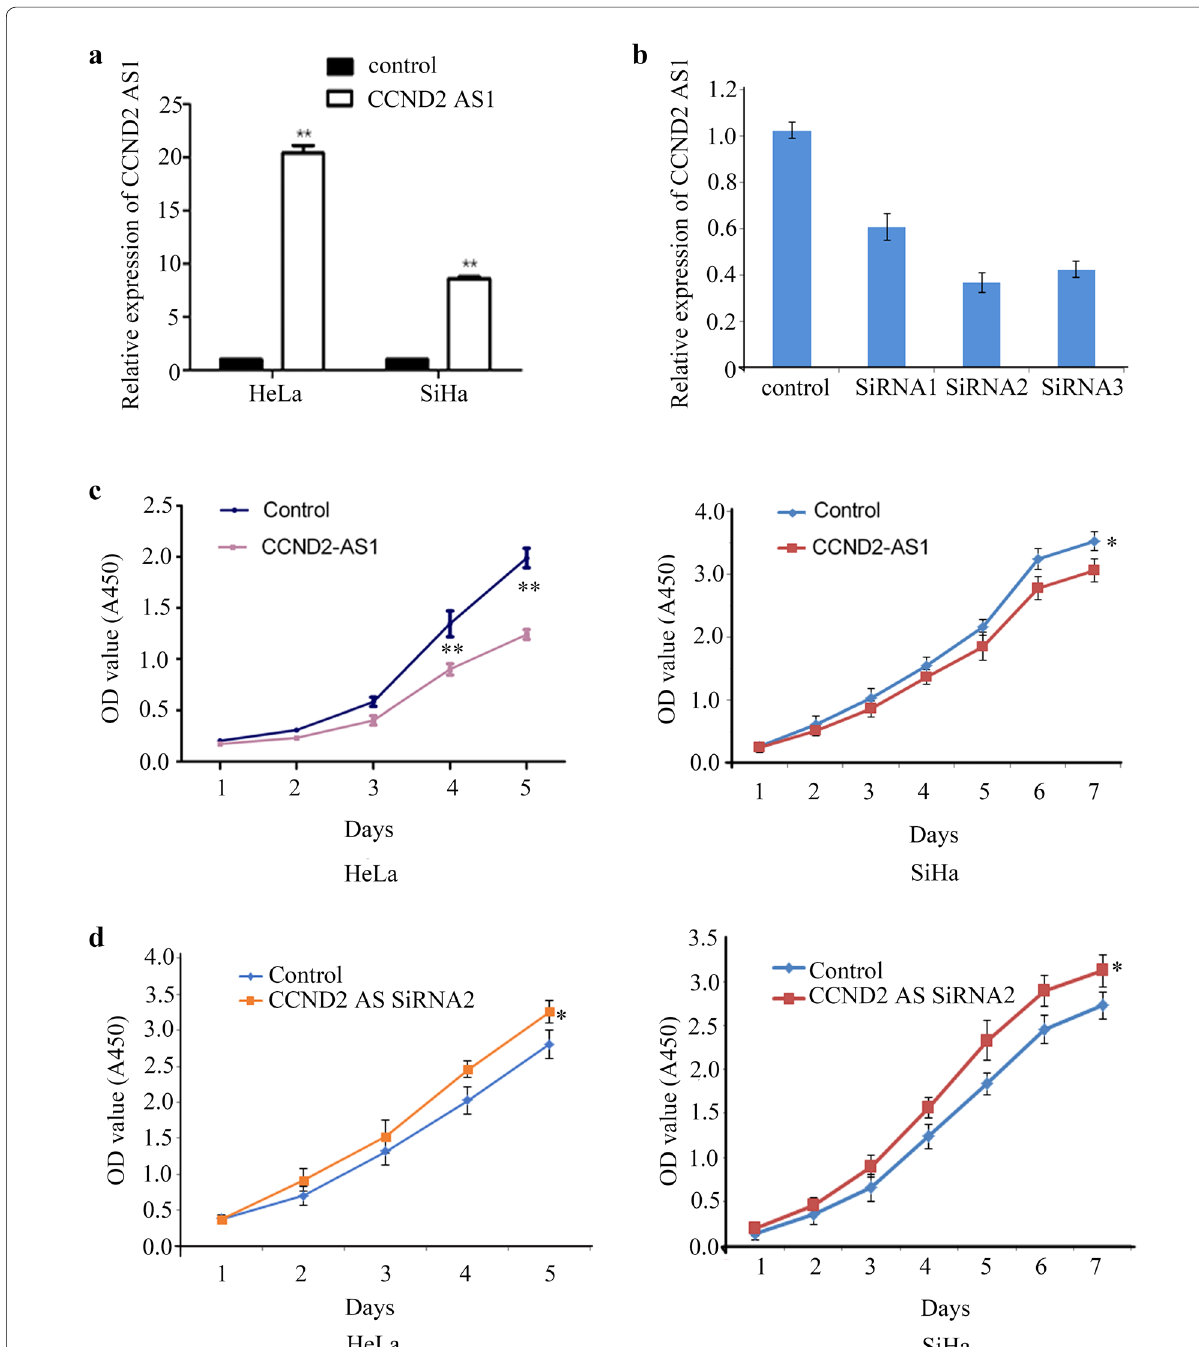
Fig. 2 CCND2 AS1 regulates cell proliferation in cervical cancer cell lines. a The CCND2 AS1 overexpression efficiency was detected by qRT-PCR in human HeLa and SiHa cell lines. b The knockdown efficiency of CCND2 AS1 SiRNAs in HeLa and SiHa cell lines were validated by qRT-PCR. c Enforced expression of CCND2 AS1 inhibited cell proliferation in HeLa and SiHa cell lines. * p < 0.05, ** p < 0.01. d Knockdown of CCND2 AS1 expression by siRNA2 promoted cell proliferation in HeLa and SiHa cell lines. * p <